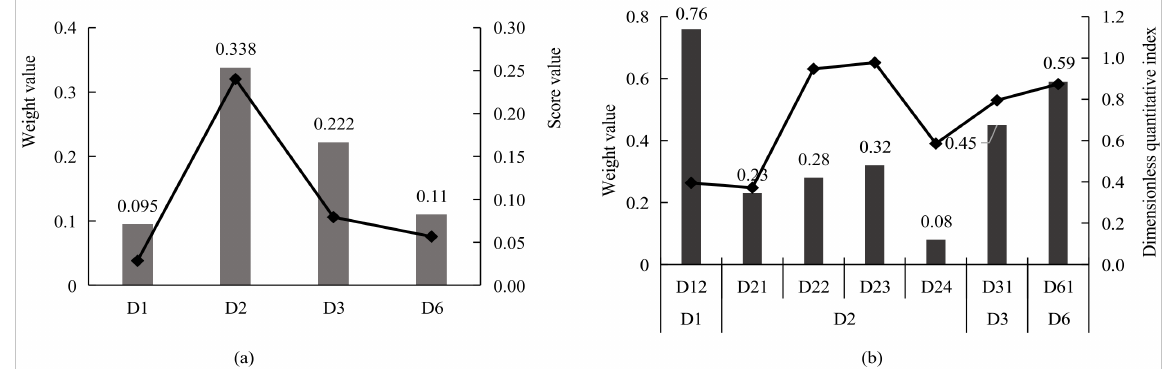
Figure 6. Score value of building energy-saving technology. ( a ) refers to the weight value and score value of the first level index, and ( b ) refers to the weight value of the second level index and the value after dimensionless quantitative